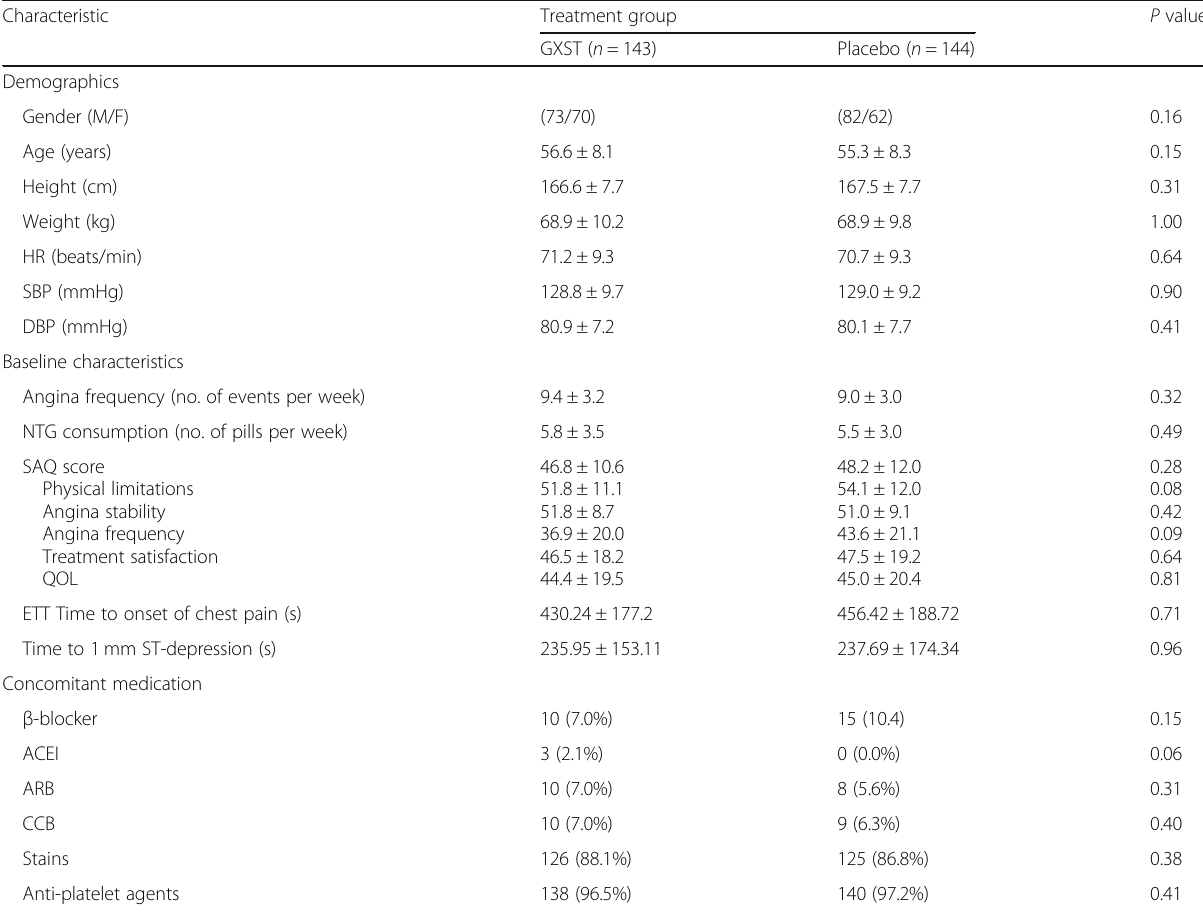
Table 1 Baseline Characteristics and Concomitant Medications Characteristic Treatment group